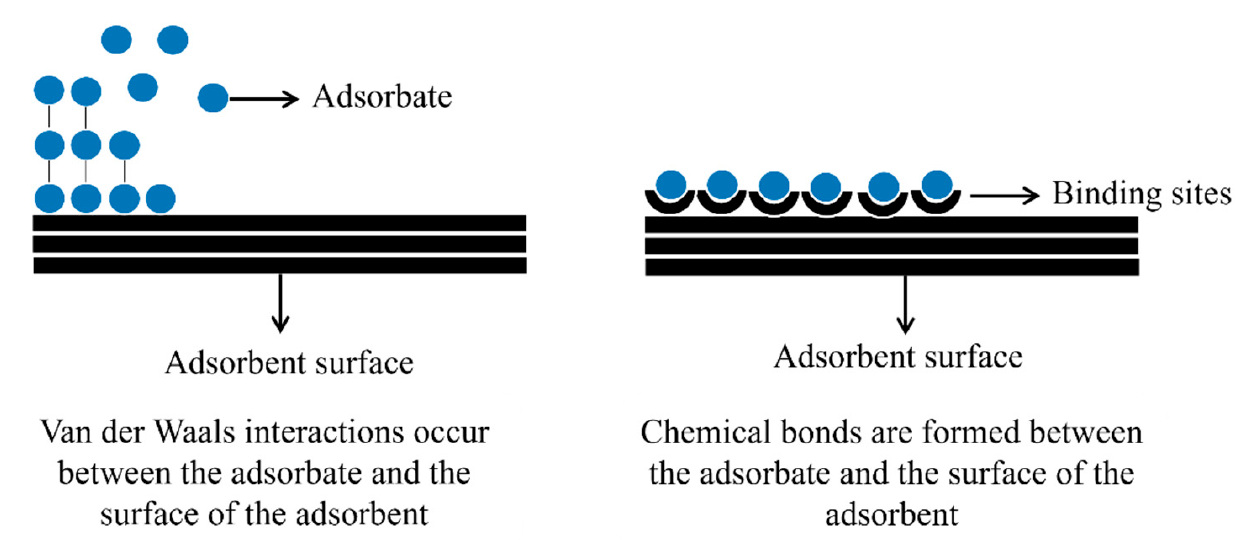
Figure 2. Illustration of the adsorption process in mono and multilayer.